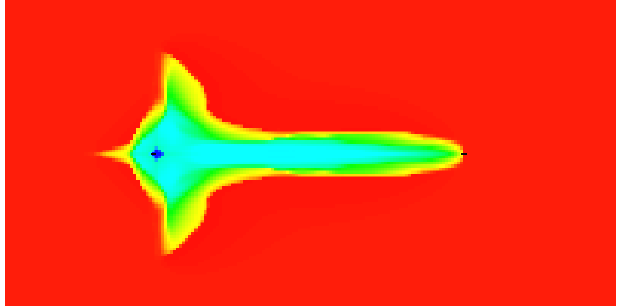
Figure 5. Distribution of formation oil saturation at 100 days of production.